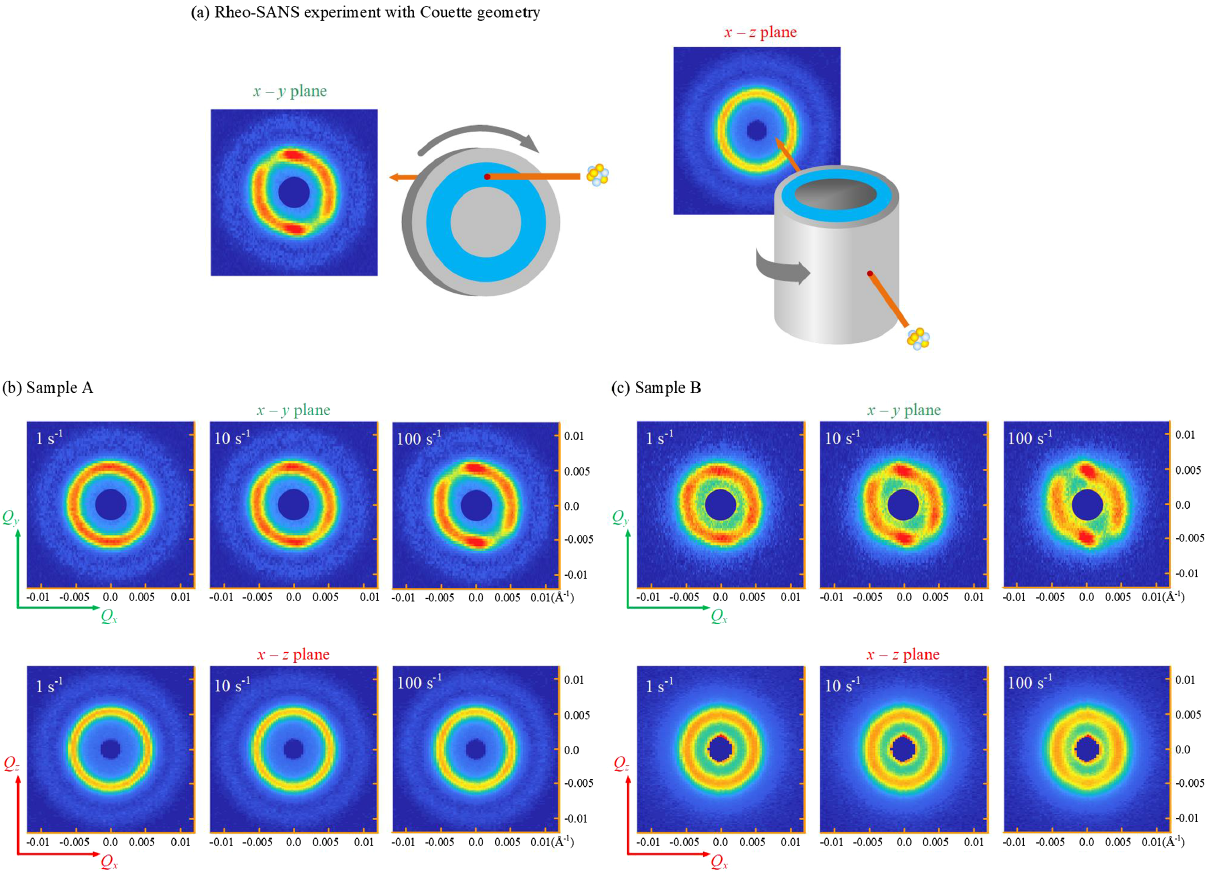
FIG. 10. (a) Illustration of the rheo-SANS experiment under Couette geometry. x , y , and z denote the directions of flow, velocity gradient, and vorticity, respectively. (b) 2D SANS patterns obtained from the x – y plane and the x – z plane at _ γ ¼ 1 , 10, and 100 s − 1 for sample A . (c) 2D SANS patterns obtained from the x – y plane and the x – z plane at _ γ ¼ 1 , 10, and 100 s − 1 for sample B . We do not see long-range ordering in all measured 2D patterns. The sample thicknesses along the neutron beam are 5 and 2 mm for the x – y plane and the x – z plane,